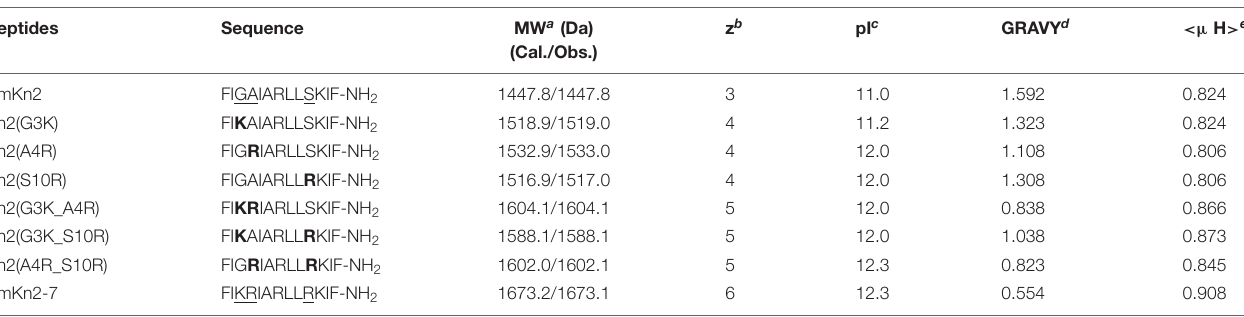
TABLE 1 | Physicochemical parameters of the peptides designed from